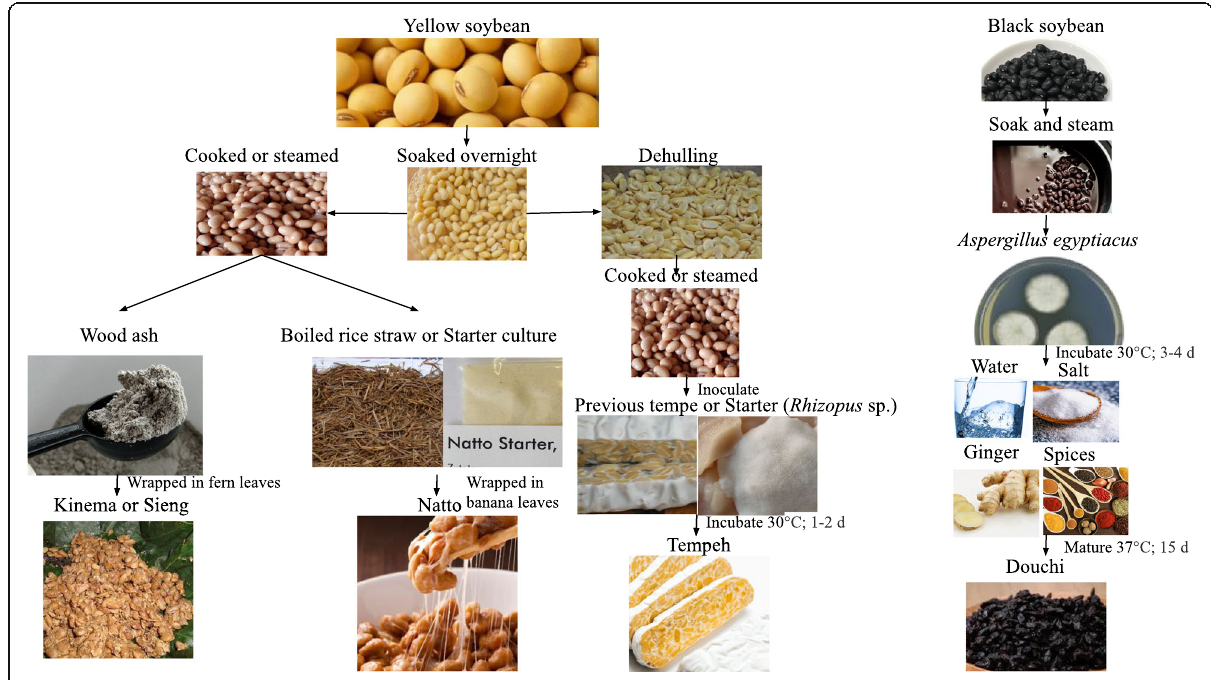
Fig. 1 Fermentation process of yellow soybean and black